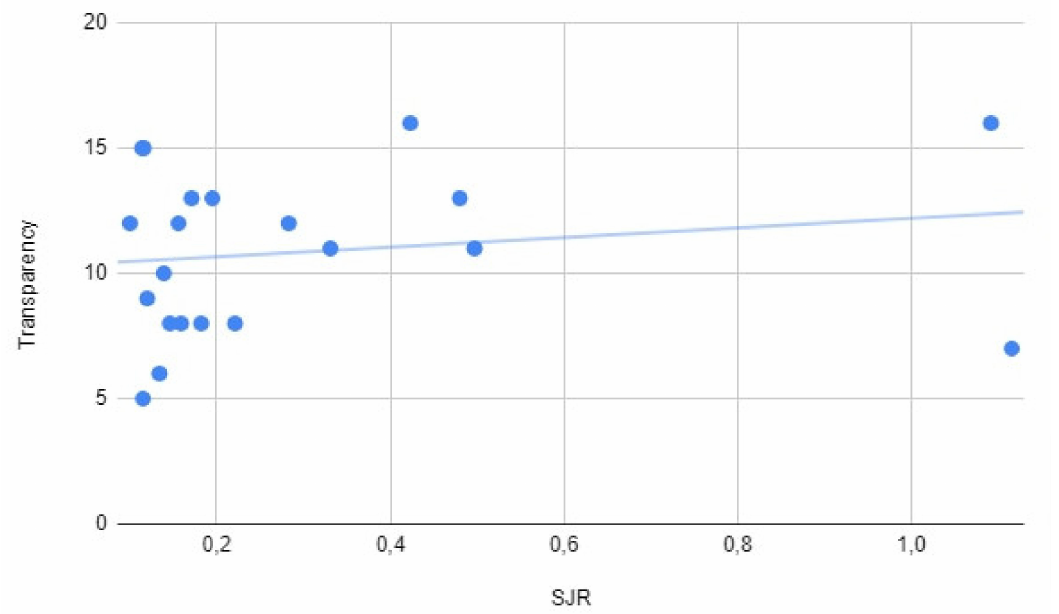
Figure 5. Diagram of the correlation between the compliance value and the Scimago Journal & Country